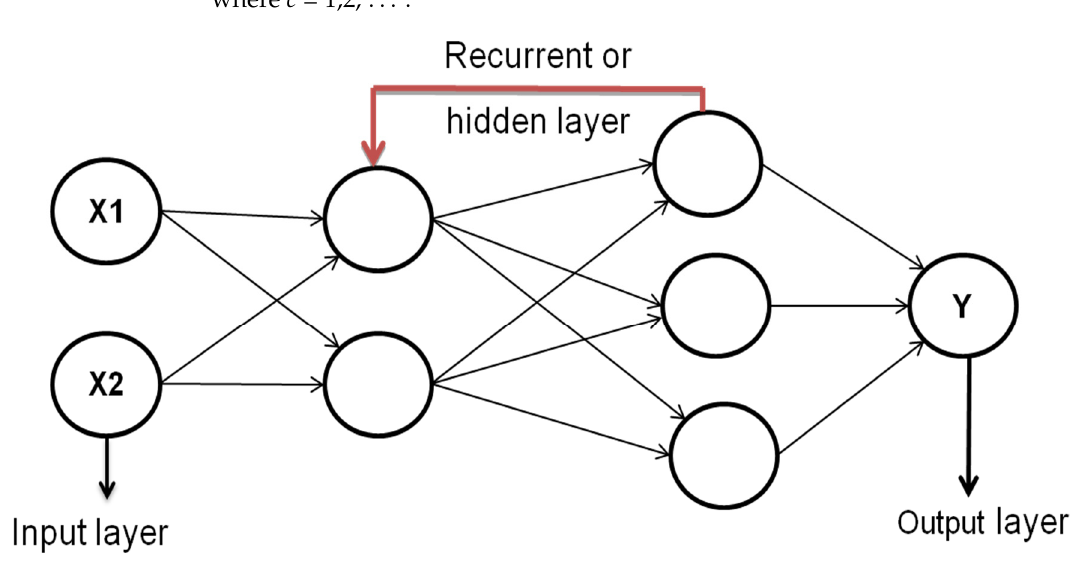
Figure 4. Framework of RNN [Source: Author]. According tothe network inputs, activation function fc is determined. Based on the activation functions, the functions of hidden node are constructed. The activation